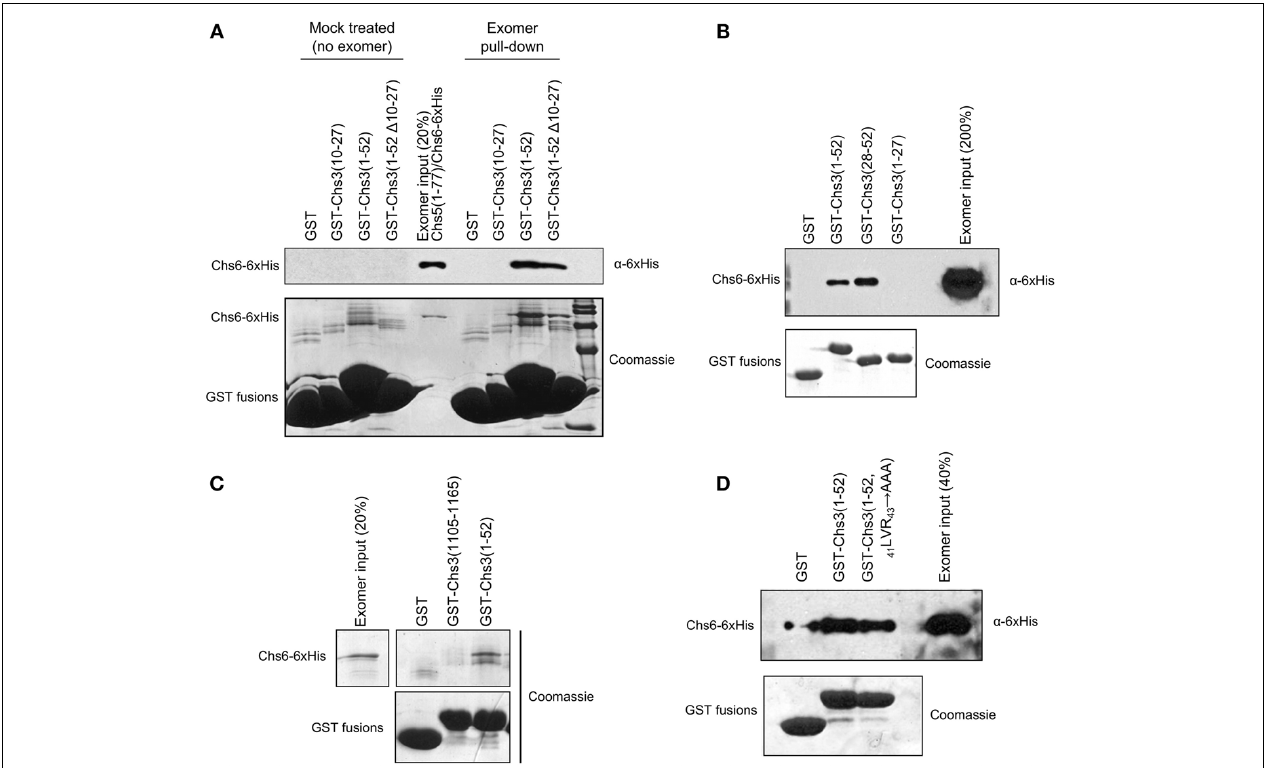
FIGURE 5 | Residues 28–52 interact with exomer in vitro . (A) In vitro interaction assay to measure ability of GST-tagged Chs3 fragments to interact with purified exomer complex. Exomer was detected by α -6xHis antibody which recognized His-tagged Chs6. GST-tagged constructs were detected by Coomassie. In the “mock treated” samples, the final exomer purification